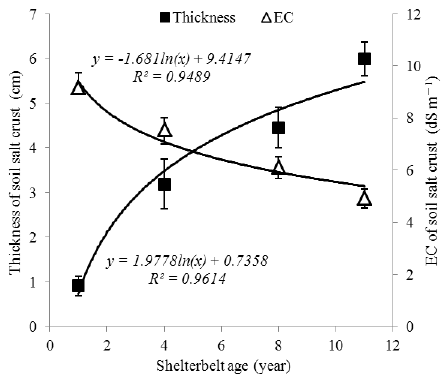
Figure 7. Annual variations in soil salt crust thickness and EC in Taklimakan Desert Highway Shelterbelt irrigated with 4.04 g·L − 1 groundwater. Error bars show 1 standard deviation.